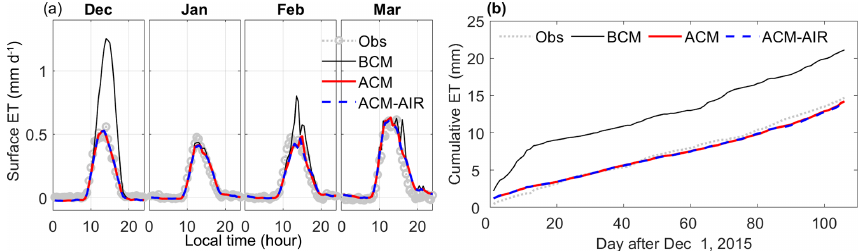
Figure 6. Comparison of observed and model-simulated (a) mean diurnal variations in surface evapotranspiration and (b) cumulative evap- otranspiration (ET) by the basic coupled model (BCM), advanced coupled model (ACM), and advanced coupled model with airflow (ACM–